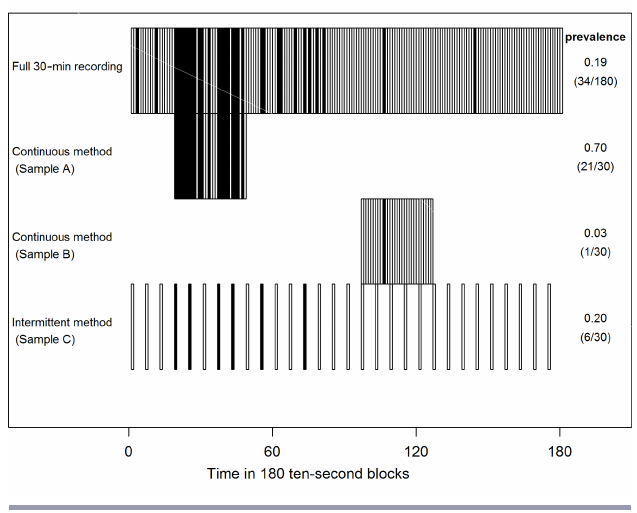
Fig. 1 . Schematic representation of a hypothetical 30-minute acoustic recording (top row) and the two subsampling methods. Each bar represents a single 10-second section of recording; black bars show intervals where a bird call was detected and white rectangles show where a bird call was not detected. Sample A, using the continuous sampling method, generated an overly high estimate of the underlying call rate because the sample happened to fall within a period of high vocal activity. Sample B sampled a period of low vocal activity, therefore the same method generated a prevalence index of just 0.03 (1/30). The noncontinuous method, Sample C, estimated a prevalence index of 0.20 (6/30) which was closer to the true prevalence from the entire 30 minute recording (0.19 or